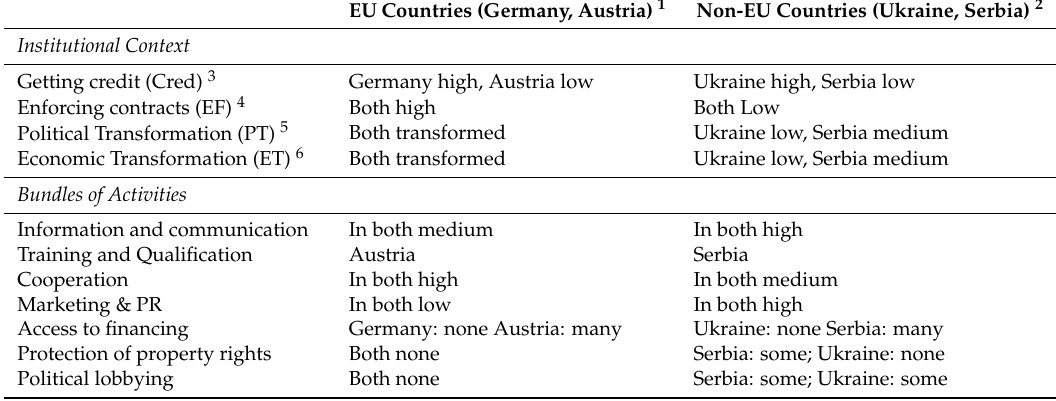
Table 3. Cross-case synthesis of institutional factors and activity